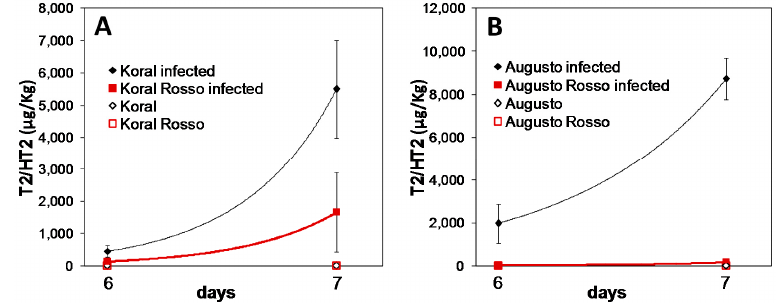
Figure 3. Accumulation of T-2/HT-2 toxins in dehulled caryopses of: ( A ) Koral (white caryopsis) and Koral Rosso (red caryopsis) and ( B ) Augusto (white caryopsis) and Augusto Rosso (red caryopsis), incubated at 10 °C on agar in the presence of Fusarium sporotrichioides spores. Toxins were analyzed after six and seven days from inoculation. Data for the two white/red grain genotype pairs were merged (thereby considering the grain colour type only, not the genotypes) and ANOVA showed a significant effect ( p < 0.05; n = 4–6 data for each mean/point) of both grain type (red/white), fungal treatment (presence/absence of F. sporotrichioides inoculum) and sampling day, as well as of their two-term interactions and of the three-term